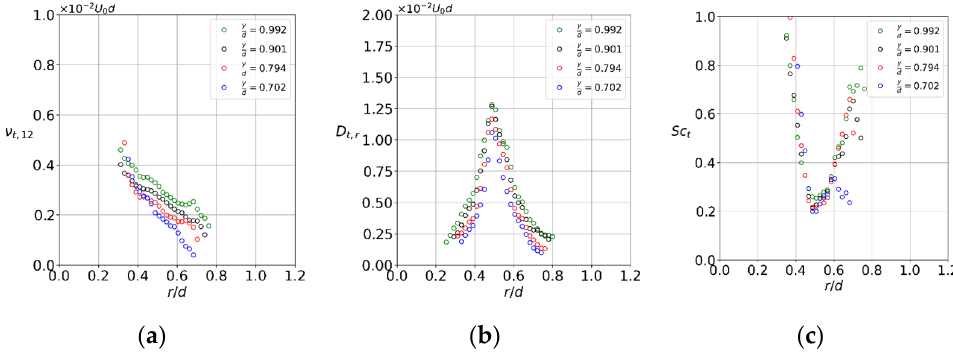
Figure 8. ( a ) Turbulent viscosity, ( b ) turbulent diffusivity, and ( c ) turbulent Schmidt number for nonswirling jet.